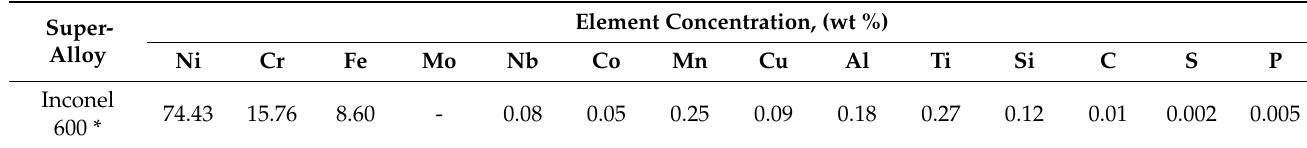
Table 1. Chemical composition of the investigated inconel superalloy.